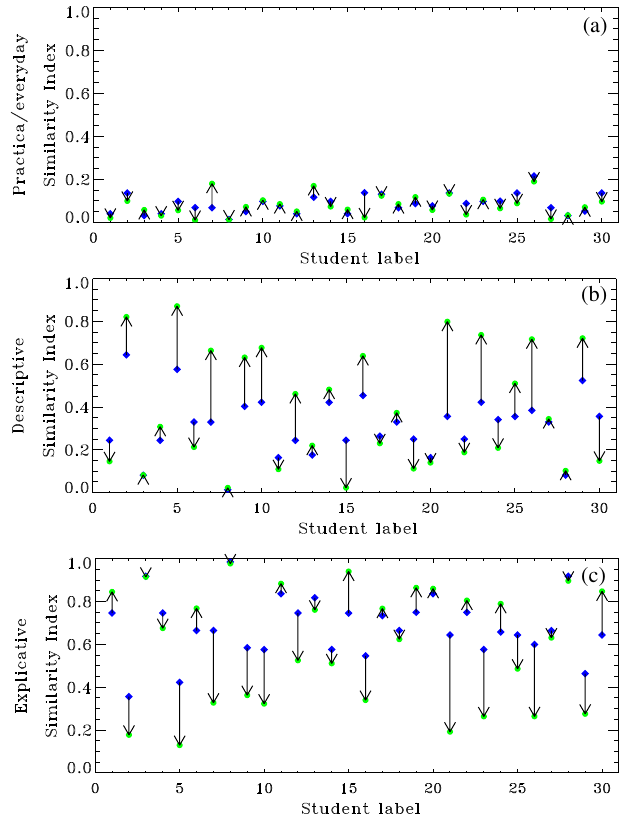
FIG. 4. Similarity indexes for all the students, each one labeled by an integer index on the abscissa, to the pe-type (a), de-type (b), and ex-type (c). For each student, blue diamonds and green circles connected by an arrow distinguish postinstruction data from those collected four years later. the x axis, two different symbols are used to distinguish postinstruction (blue diamonds) from post-4y-instruction (green circles) similarity indexes, connected by an arrow helping to visualize the temporal evolution.